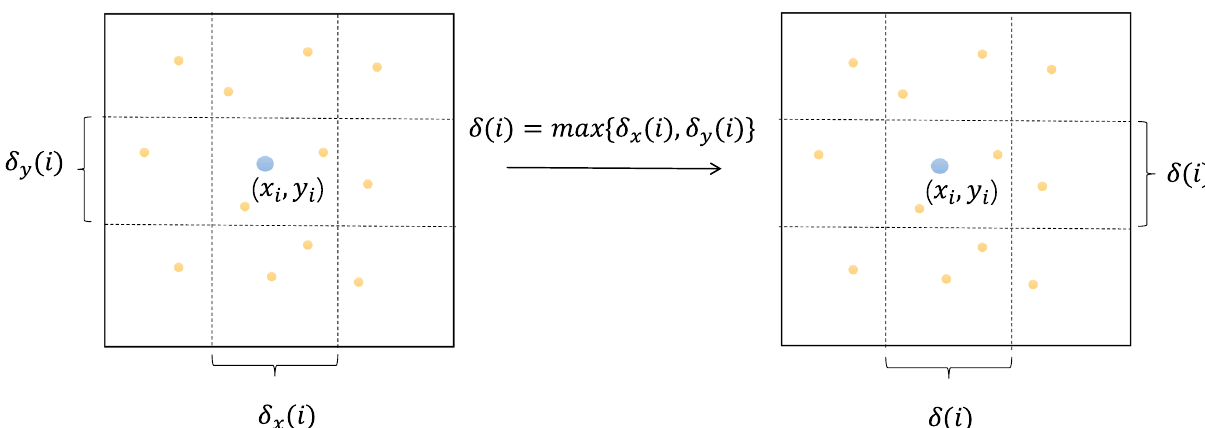
Figure 1. An example of KNN-MI